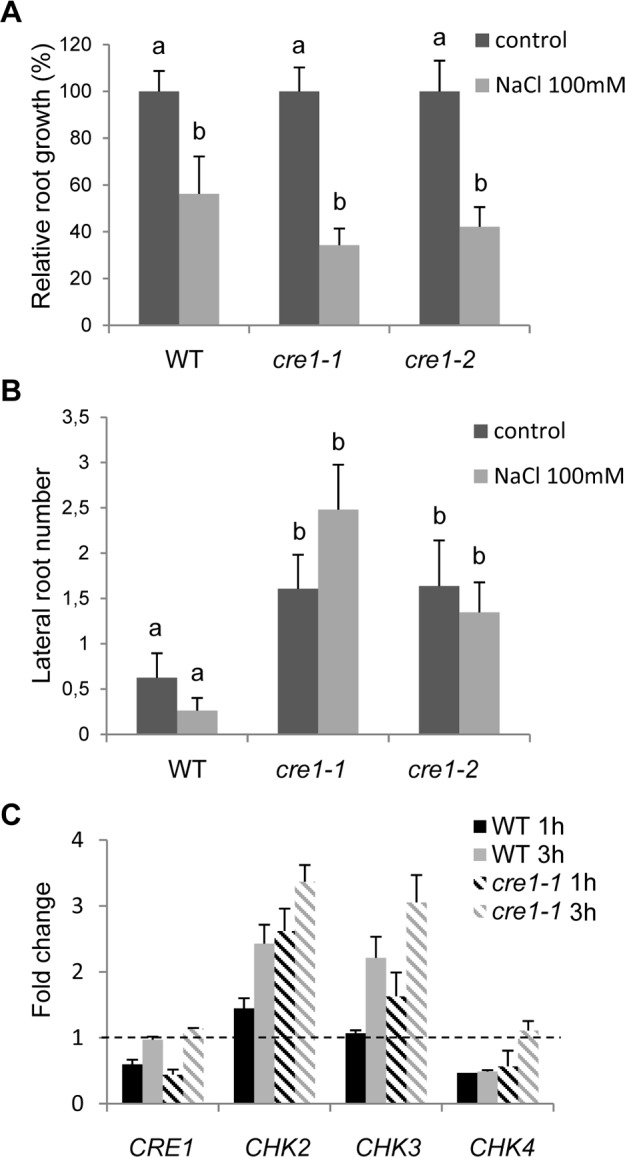

cre1 mutants form an increased number of lateral roots under control and salt stress conditions.
A. Root length in the Wild-Type (WT) and in the cre1 mutant (cre1-1 and cre1-2 alleles) was quantified after 7 days on a nitrogen-starved medium (“i” [13]) containing salt (100mM NaCl). B. Lateral root number in the Wild-Type (WT) and in the cre1 mutant (cre1-1 and cre1-2 alleles) was determined 7 days after salt treatment (100mM NaCl). In A and B, error bars represent standard deviation (n>20) and a Kruskal-Wallis test was used to assess significant differences (shown by letters, α<0.05). C. Real time RT-PCR of putative cytokinin receptors expression in roots of the Wild-Type (WT) and of the cre1-1 mutant treated by salt (NaCl 100 mM) for 1 or 3 hours. Genes of interest were normalized with the reference gene MtRBP1 and calibrated with the non-treated condition (the broken line indicate a ratio of 1). Error bars represent standard deviation of two biological replicates.